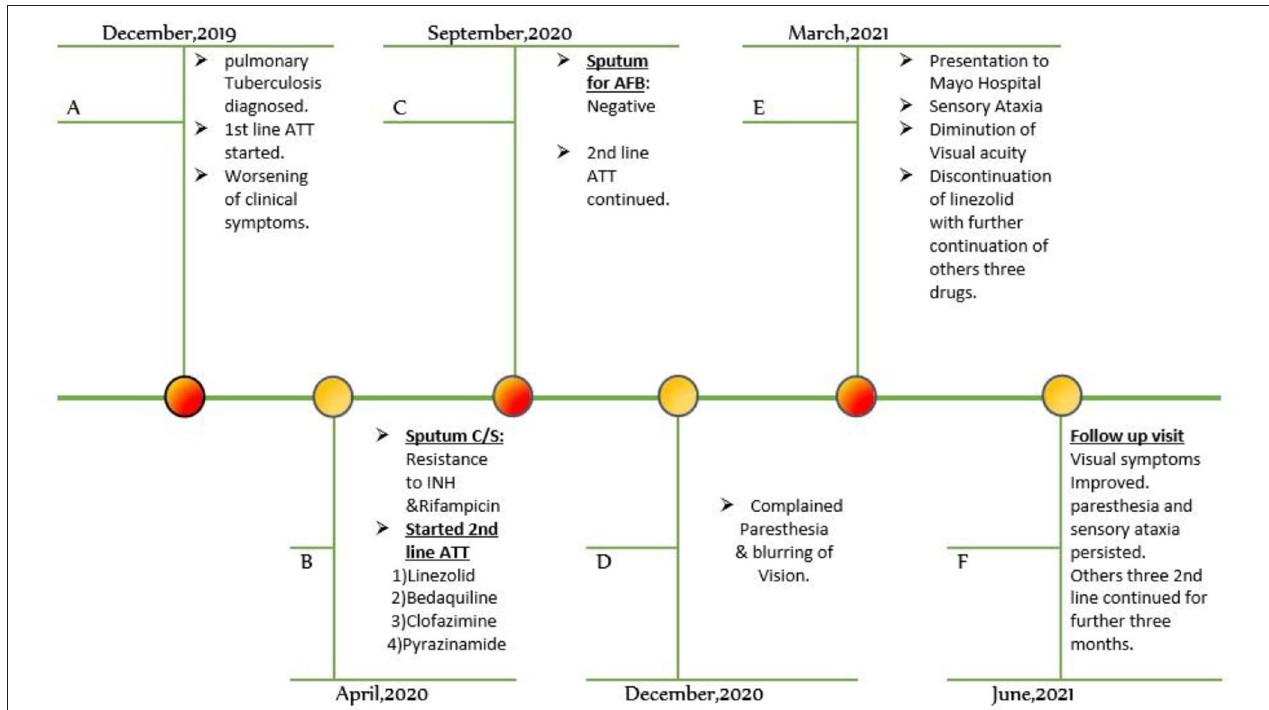
FIGURE 1 | Timeline of events. ATT, anti-tuberculous treatment, AFB. acid-fast bacilli, C/S, culture and sensitivity, INH,